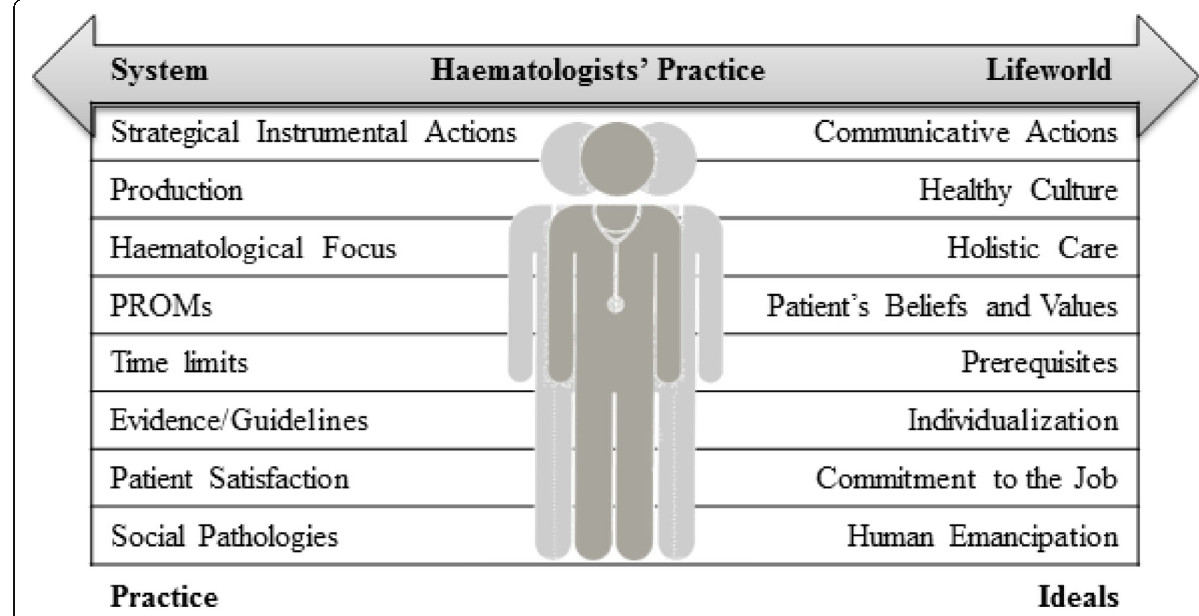
Fig. 2 Characteristic Dichotomies in Hematologists ’ Practice Inspired by Habermas and